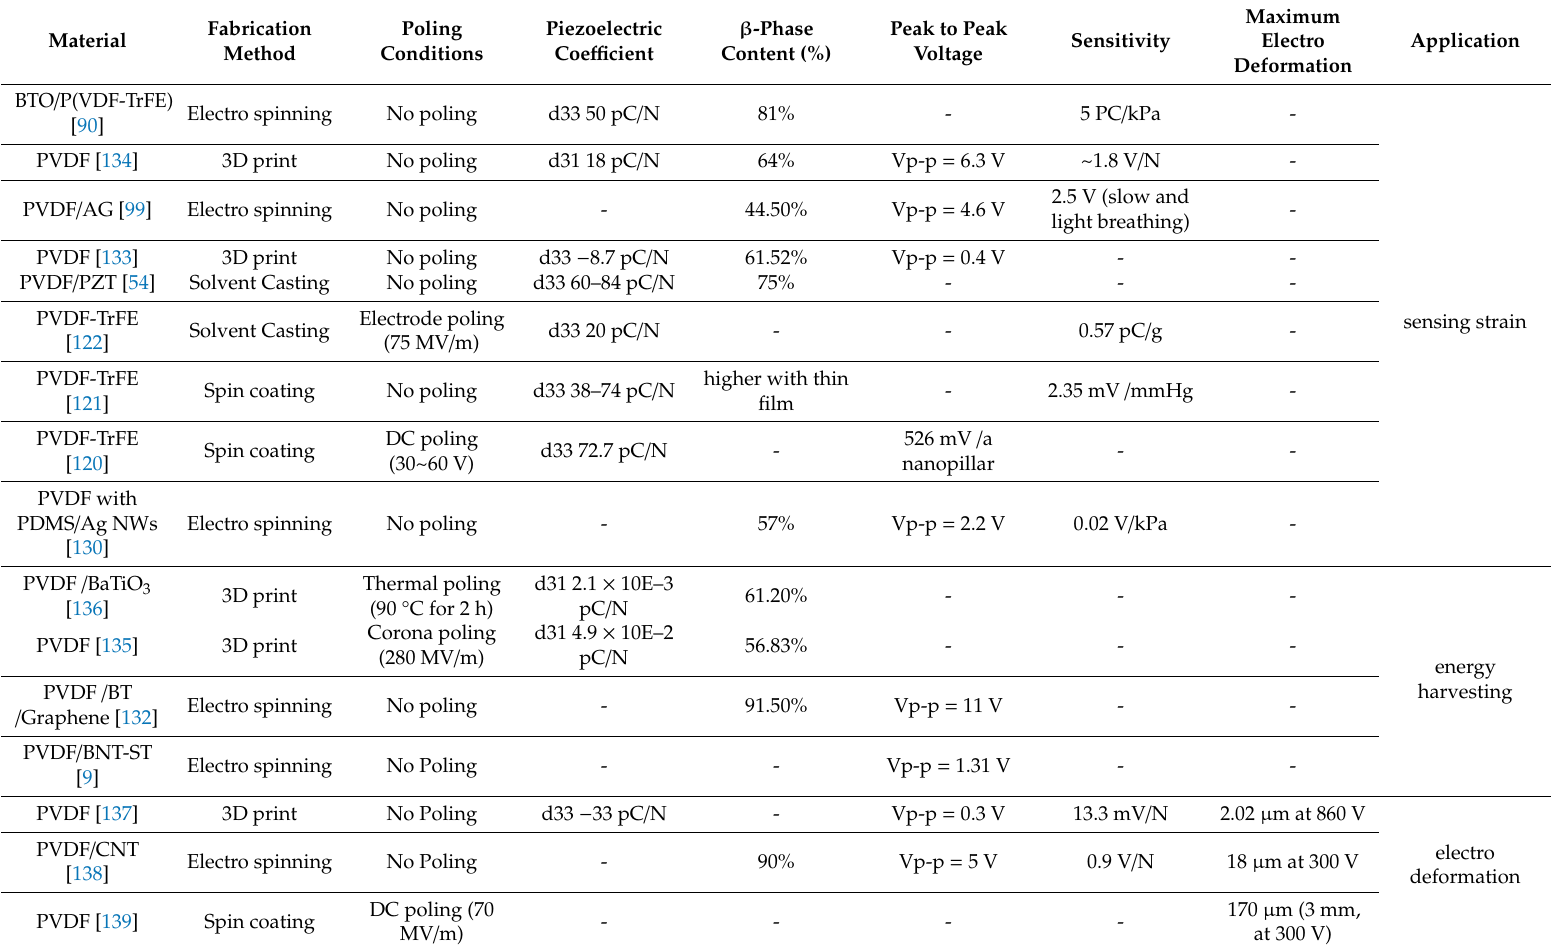
Table 2. Fabrication methods, polarization, description and comparison of the performance of